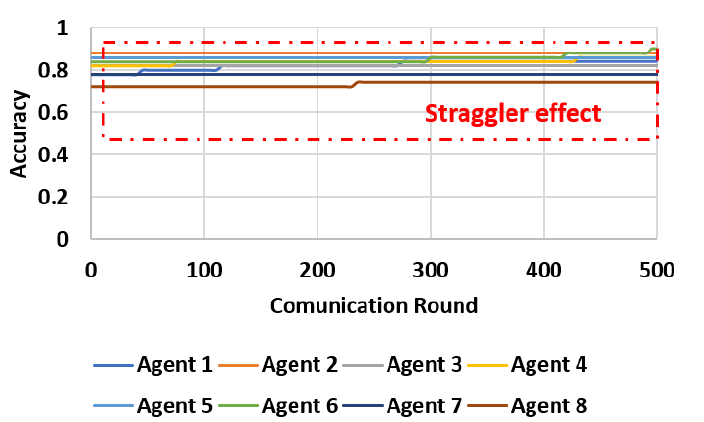
Figure 14. Straggler effects on participating FL agents’ (eight agents and six stragglers) model accuracy for the prediction of agents’ resource-sharing capability.